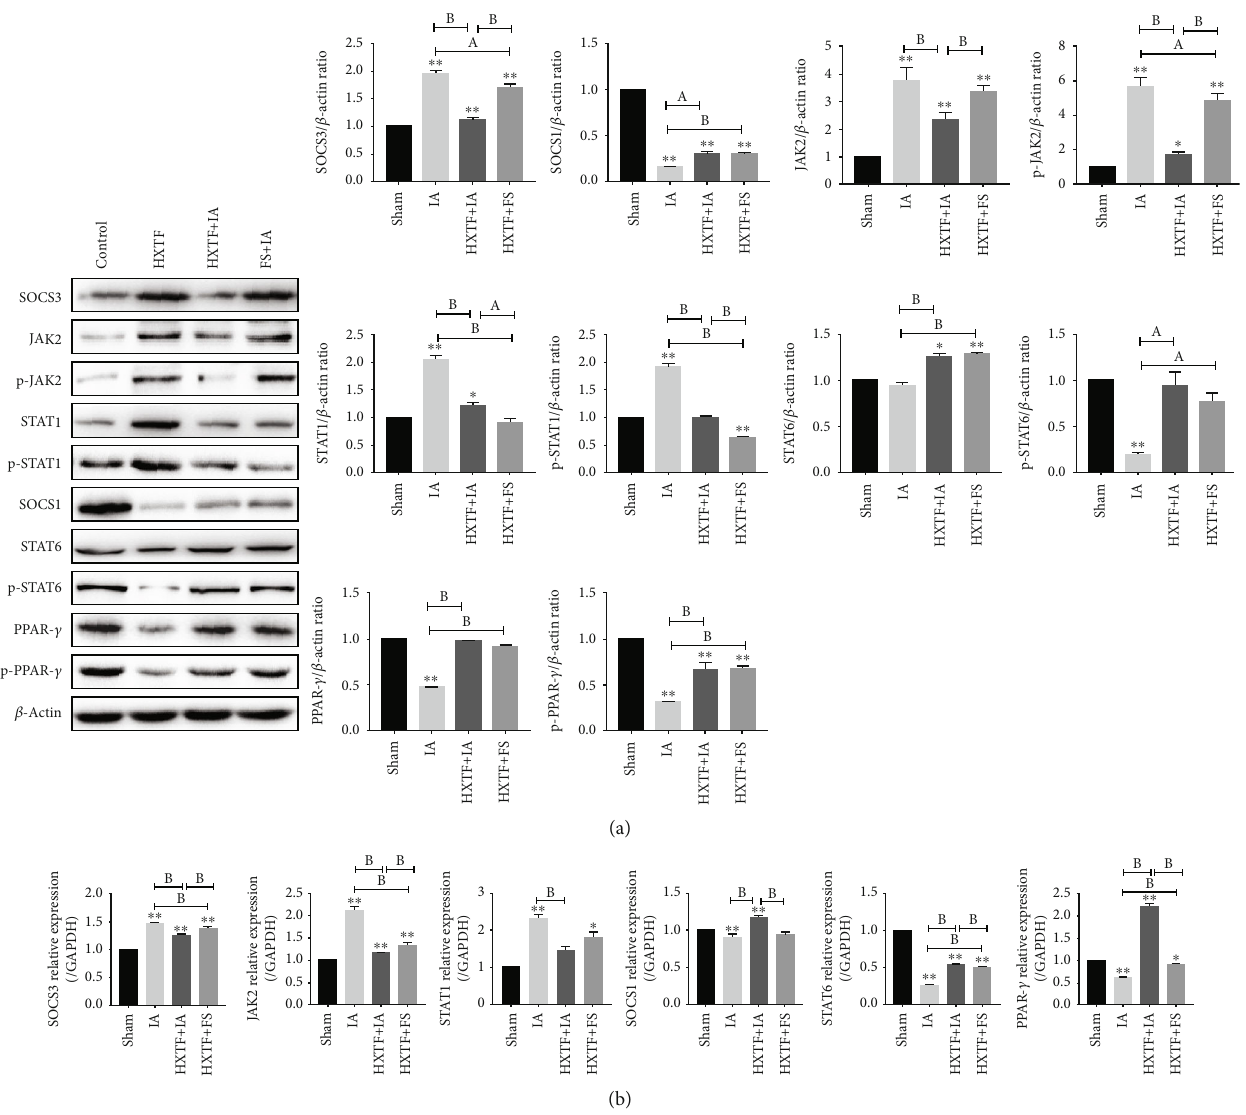
Figure 9: Expression of the SOCS/JAK2/STAT/PPAR- γ pathway in intraperitoneal adhesion tissues. (a) Representative Western blot analysis showing SOCS/JAK2/STAT/PPAR- γ pathway protein expression levels. (b) Real-time PCR was used to quantify the relative levels of mRNA of SOCS/JAK2/STAT/PPAR- γ pathway-related factors. All values are expressed as mean ± S : E : ( n = 10 ). ∗ p < 0 : 05 , ∗∗ p < 0 : 01 , a p < 0 : 05 , and b p < 0 : 01 , comparison of the designated two